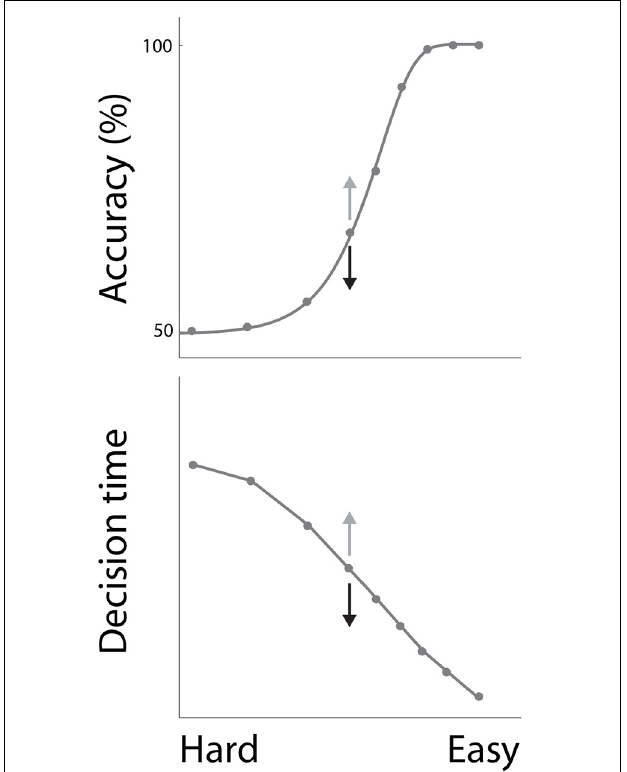
FIGURE 1 | The psychometric and chronometric curves. Decisions are faster and less accurate with increasing task difficulty, describing a relationship between speed and accuracy. For a given task difficulty, decisions are faster and less accurate under conditions favoring speed, and are slower and more accurate under conditions favoring accuracy. This phenomenon is depicted by the arrows on either side of the central data point on each curve, where speed and accuracy conditions correspond to black and gray arrows